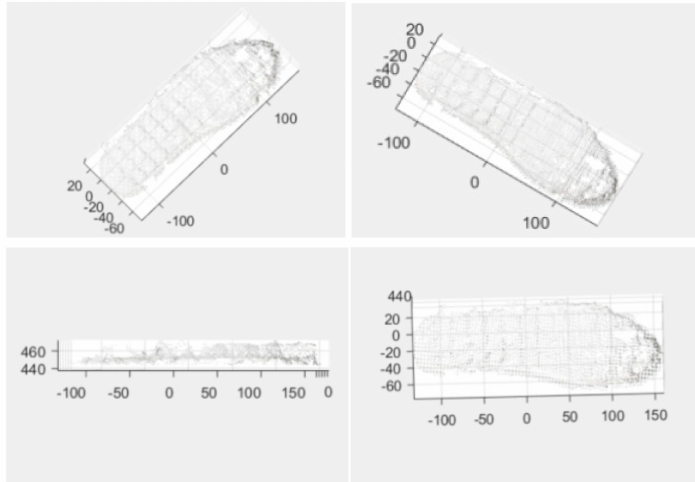
Figure 10. The filtered point cloud image of a sneaker sole.